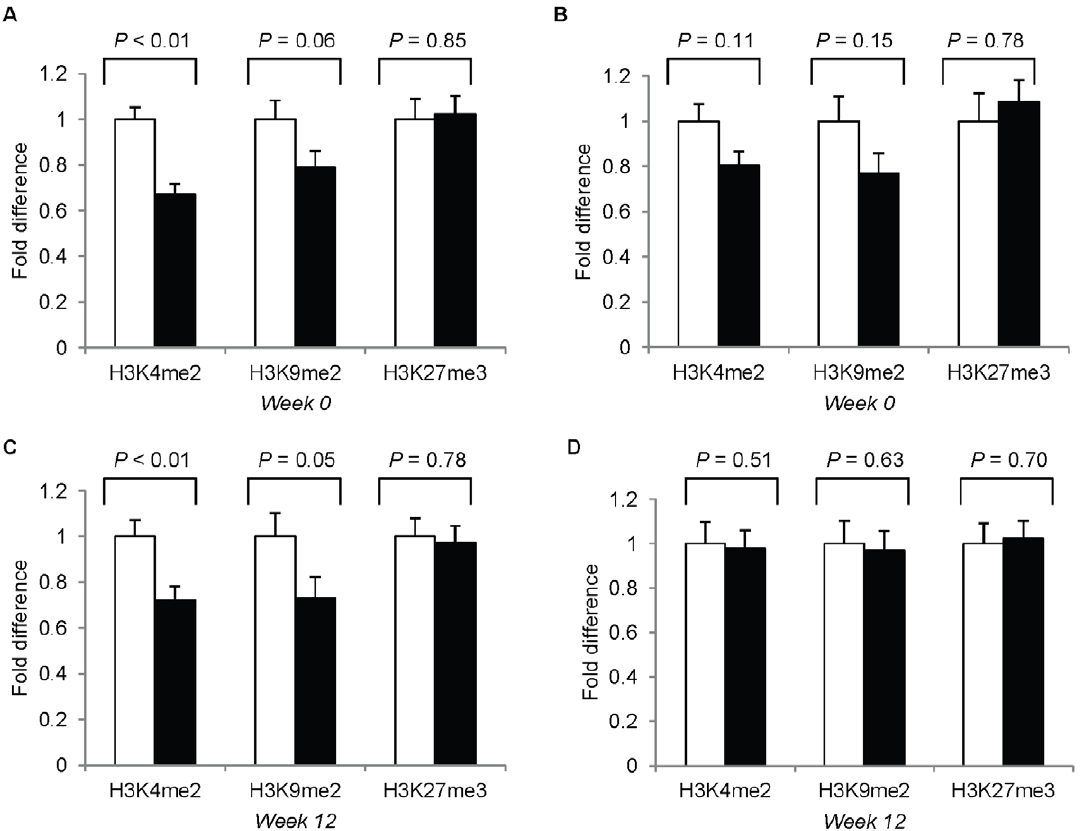
Figure 5. Peripheral blood leukocyte histone modification marks H3K4me2, H3K9me2 and H3K27me3. ( A ) and ( C ), histone modifications in third trimester pregnant versus nonpregnant women without controlling for percent granulocytes at study-baseline and study-end, respectively; ( B ) and ( D ), histone modifications in third trimester pregnant versus nonpregnant women controlling for percent granulocytes at study- baseline or study-end, respectively. White bar: nonpregnant women (n=21), black bar: pregnant women (n=26). Data are predicted means 6 SEM. Analyzed with general linear models.